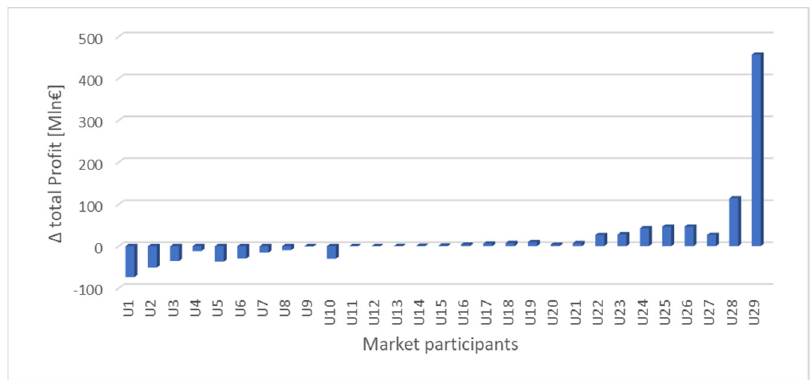
Figure 18. Total profit increase when the RR auction is in place.